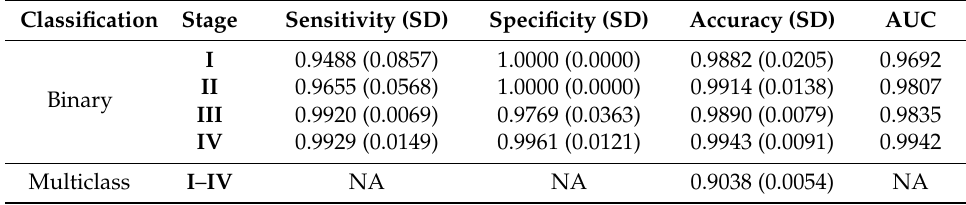
Table 2. Accuracies of the binary and multiclass classifications and predictions by machine learning. This table displayed the performances of the binary (each stage group vs. control group) and multiclass classifications (the four stage groups + normal control group) and predictions by SVM using the GSR indices computed through the GO terms. The sensitivities, specificities, areas under the curves (AUCs), accuracies and standard deviation (SD) were measured by five-fold cross-validation. Each measurement was computed from 10 cumulative results of the repeated classifications and